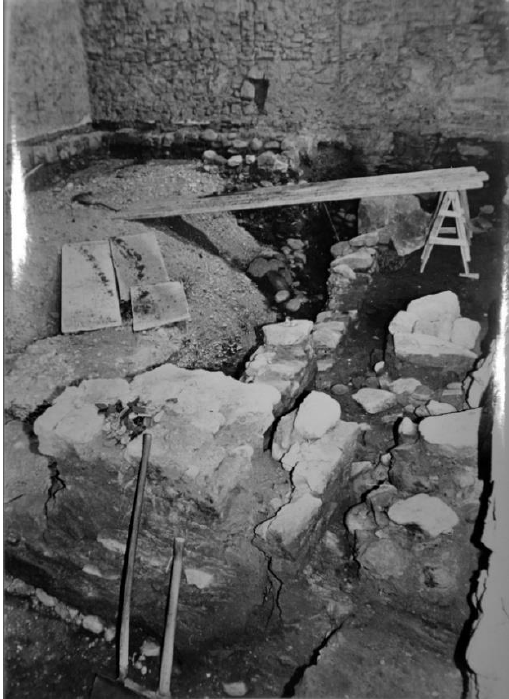
Figure 8. The expanded inner foundations, running parallel to the southern side. Interior. View of northeast corner. Photo: The Maribor Regional Office of the IPCHS, Fond Maribor—Sinagoga.